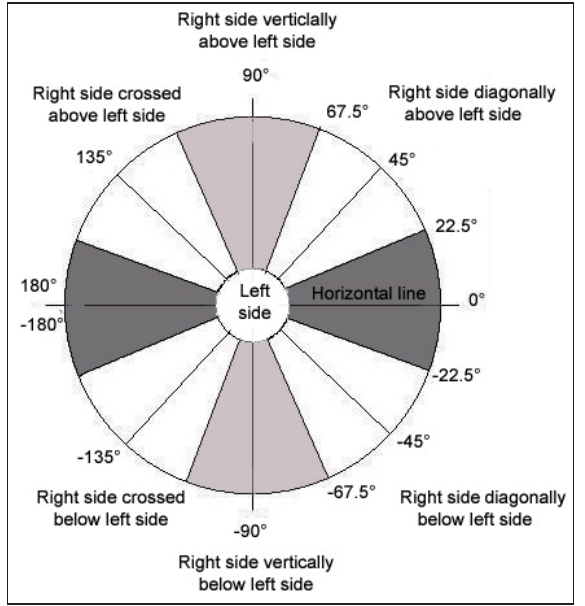
Figure 3. Upper / lower limb coordination